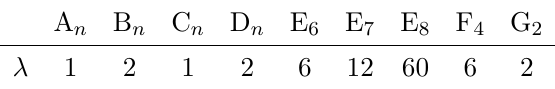
Table 1 . Normalization factors for the simple Lie